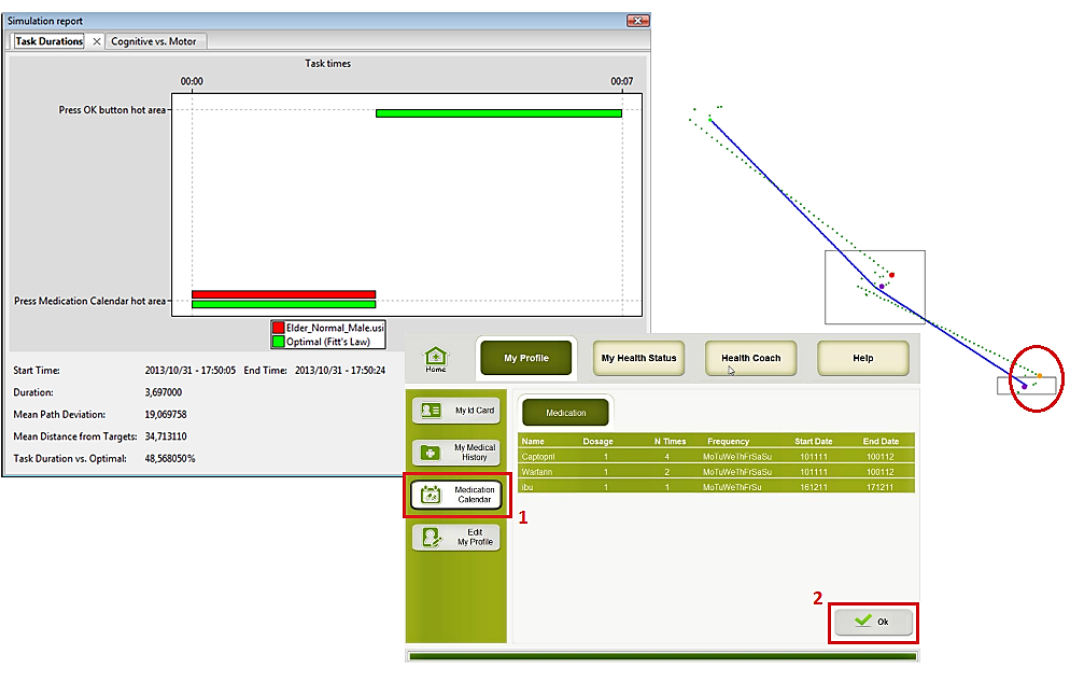
Figure 12. User 1 Cognitive VUM simulation: Check medication calendar.